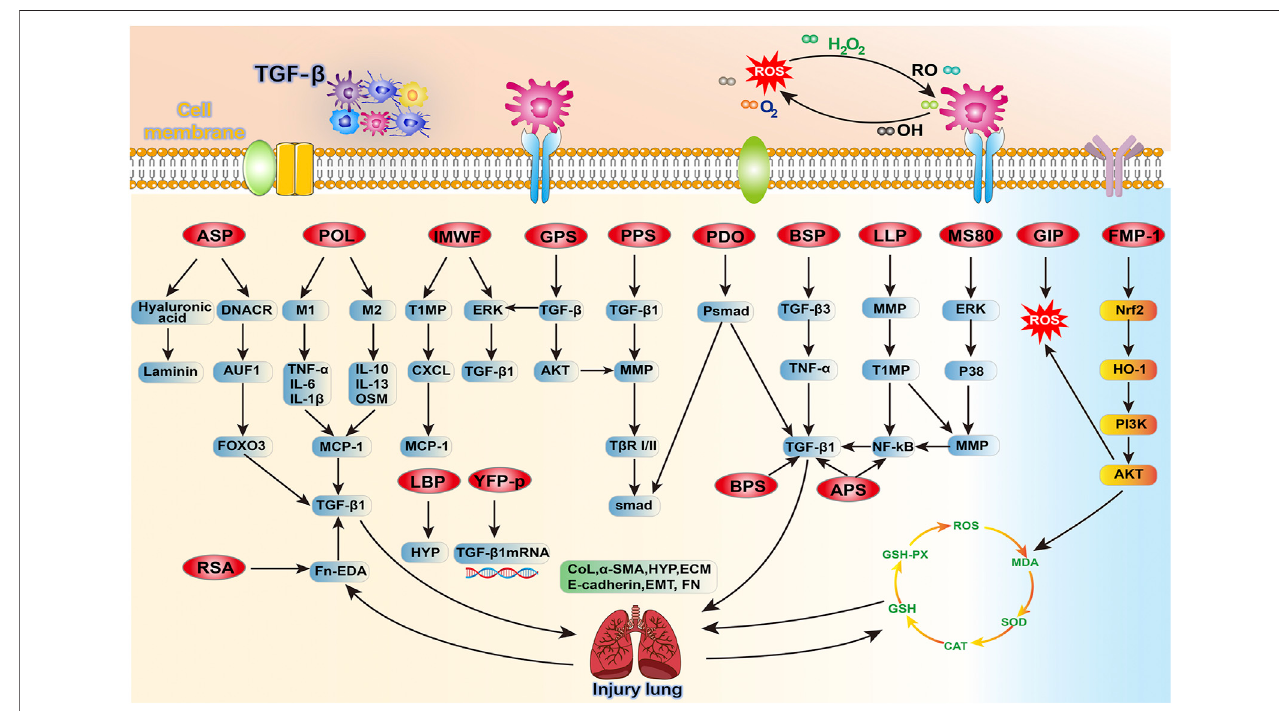
FIGURE3| An overview ofthetargetsignaling pathways of16Chineseherbalpolysaccharides that antagonize PF, mainly byreversing TGF- β and improving ROS to treat pulmonary fi brosis, and further linking the relationship with these related pathways.